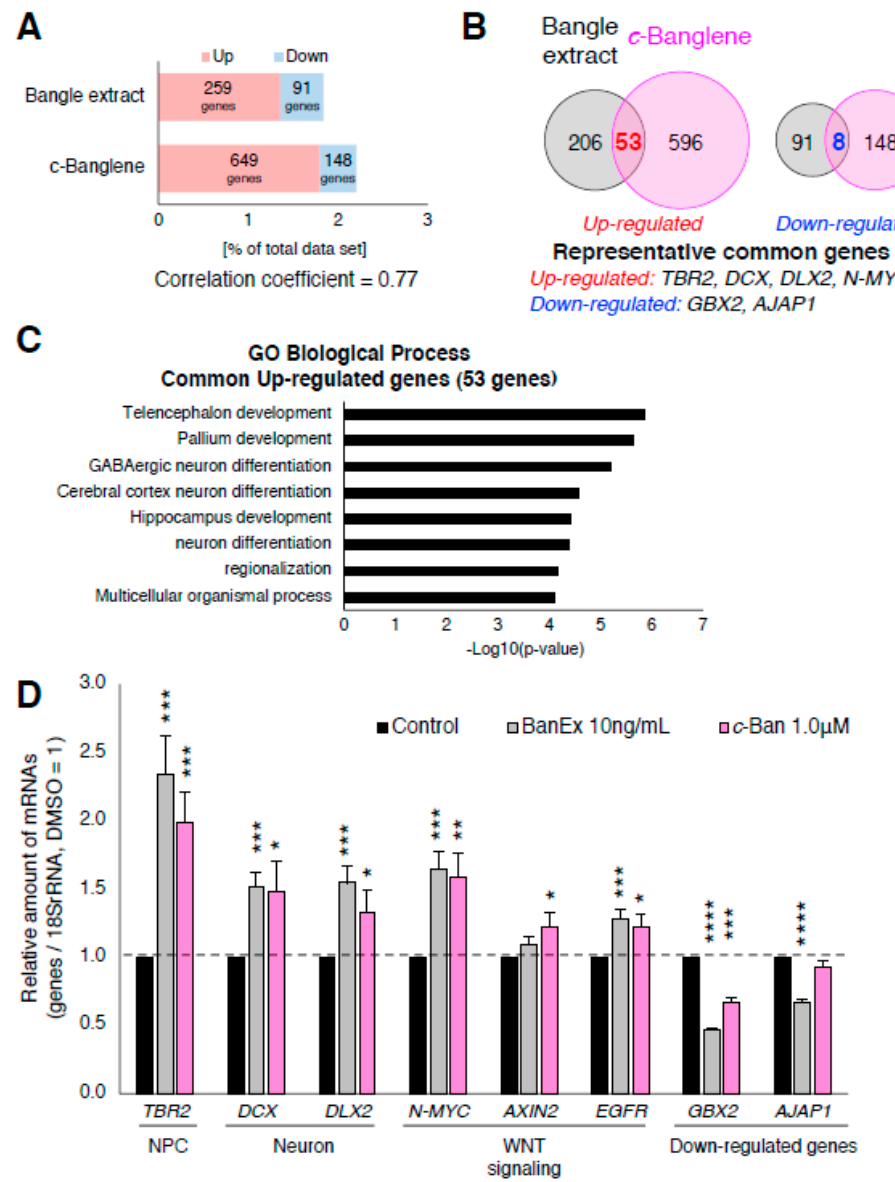
Figure 2. Bangle extract and Banglene affect the expression of genes related to neurogenesis and WNT pathway. ( A ) Microarray analysis of hfNSCs 2 days after differentiation. The graph shows percentage of up- and down-regulated genes in Bangle extract (N=3) and c -Banglene (N=2) treated cells as compared to untreated cells (upregulated gene > 1.3-fold; downregulated genes < 0.7-fold; P < 0.05). ( B ) Venn diagram of unique and shared mRNAs in Bangle extract and c -Banglene-treated cells. ( C ) Gene ontology (GO) analysis of the commonly upregulated genes. Analysis was performed by PANTHER (http://pantherdb.org/). ( D ) Quantitative RT-PCR analysis of the cells at 2 days after the induction of differentiation. Data represent mean ± SEM, when compared to control cells. ( N = 6, t -test, * p < 0.05, ** p < 0.01, *** p < 0.005, **** p < 0.001).